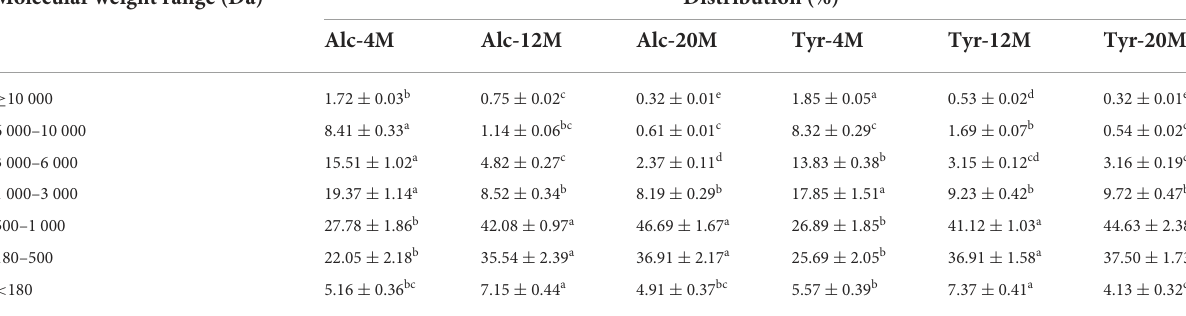
TABLE 2 The molecular weight distribution of peptides from macroporous adsorption resin